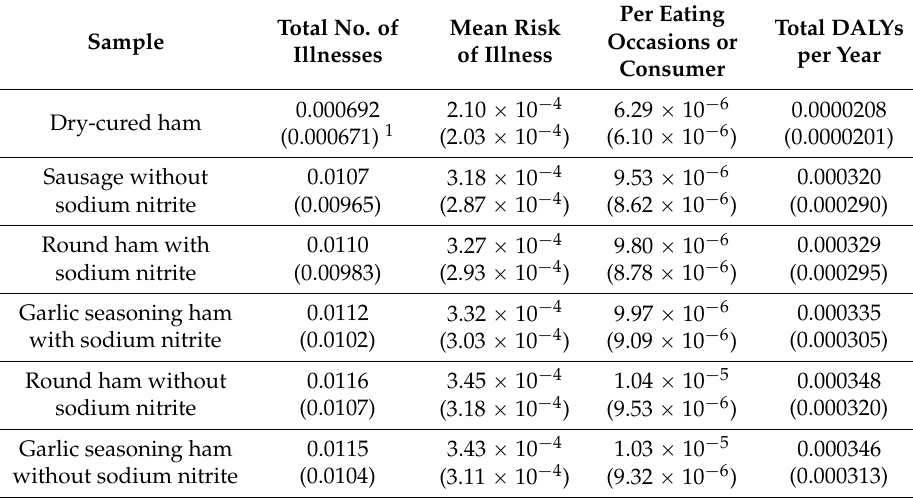
Table 4. FDA-iRISK output: risk ranking of population health burden across multiple processed meat products stored at 4 and 10 ˝